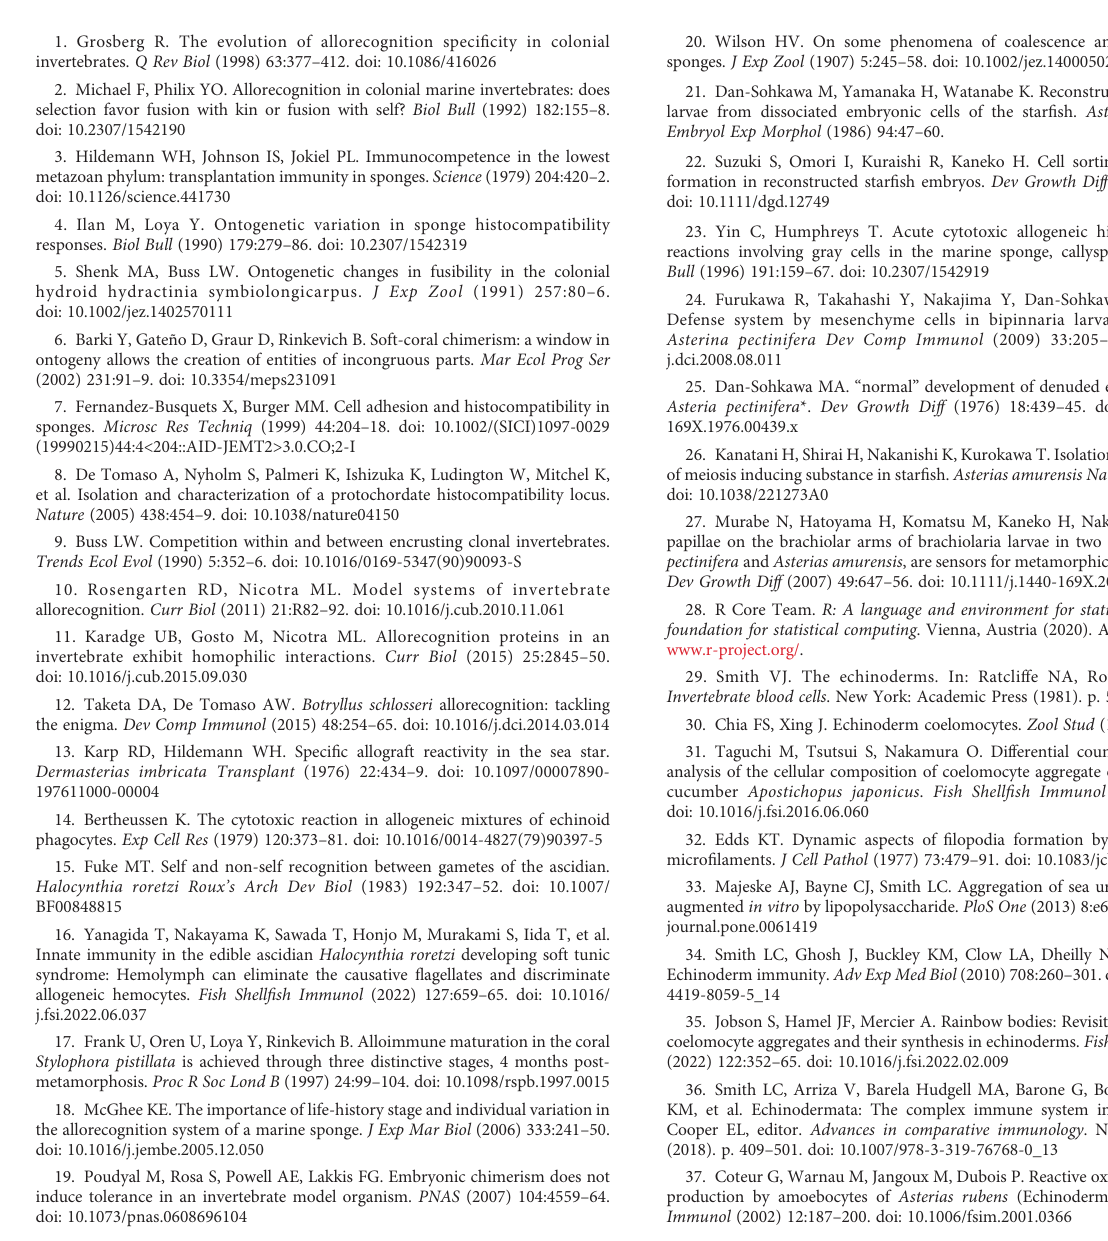
SUPPLEMENTARY FIGURE 2 Morula cell with visible nucleus in coelomocyte smears. Nucleus stained reddish purple by MG staining was identi fi ed in the cytoplasm fi lled with basophilic granules. N: nucleus. Scale bar: 10 µm. SUPPLEMENTARY FIGURE 3 Coelomocyte that formed an aggregate in response to injected Escherichia coli . Magni fi ed image of outer edge of the aggregate. Bacterial challenge was performed according to a previously described method [Furukawa et al., Dev Comp Immunol. (2012) 36, 51 – 61]. Arrowheads indicate phagocytosed bacteria. Similar to the